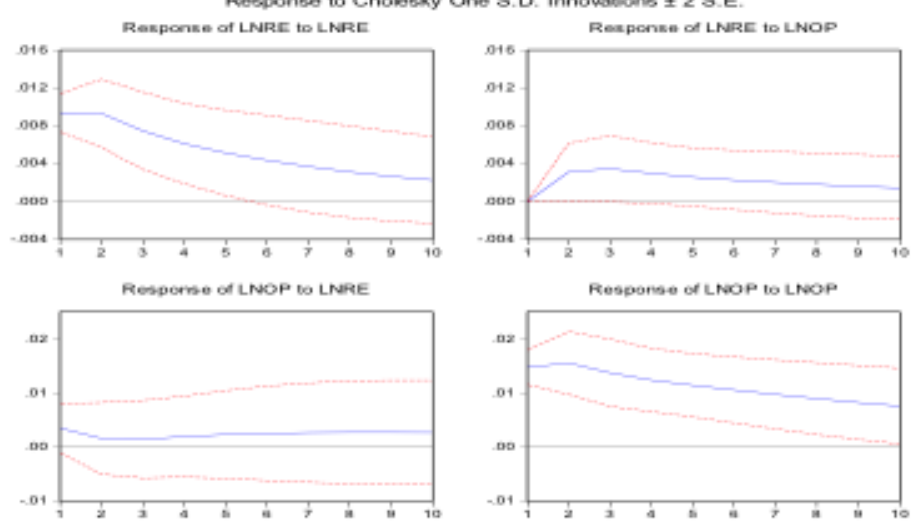
Figure 3. Impulse response diagram of yen exchange rate and international crude oil price fluctuations